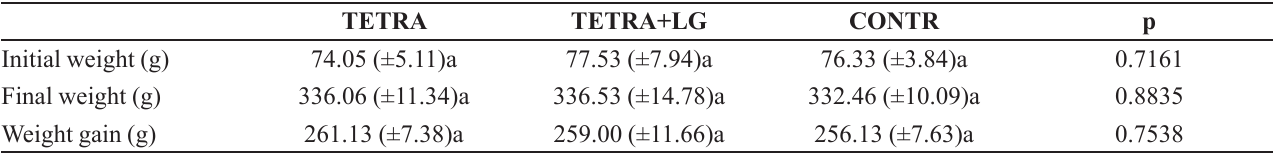
TABLE I - Initial weight, final weight, and weight gain of animals [mean (± SD)] for each group